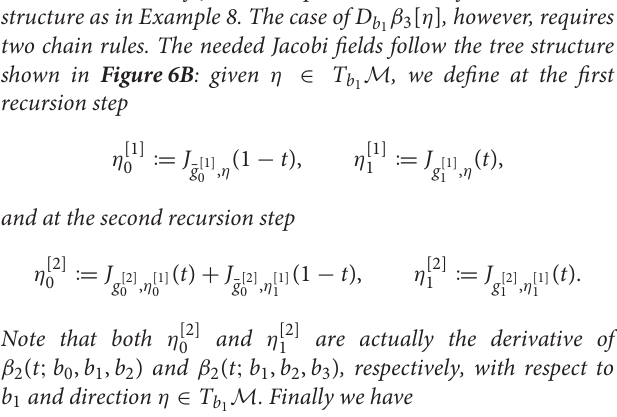
Figure 5 represents one level of the schematic propagation tree to compute the derivative of a Bézier